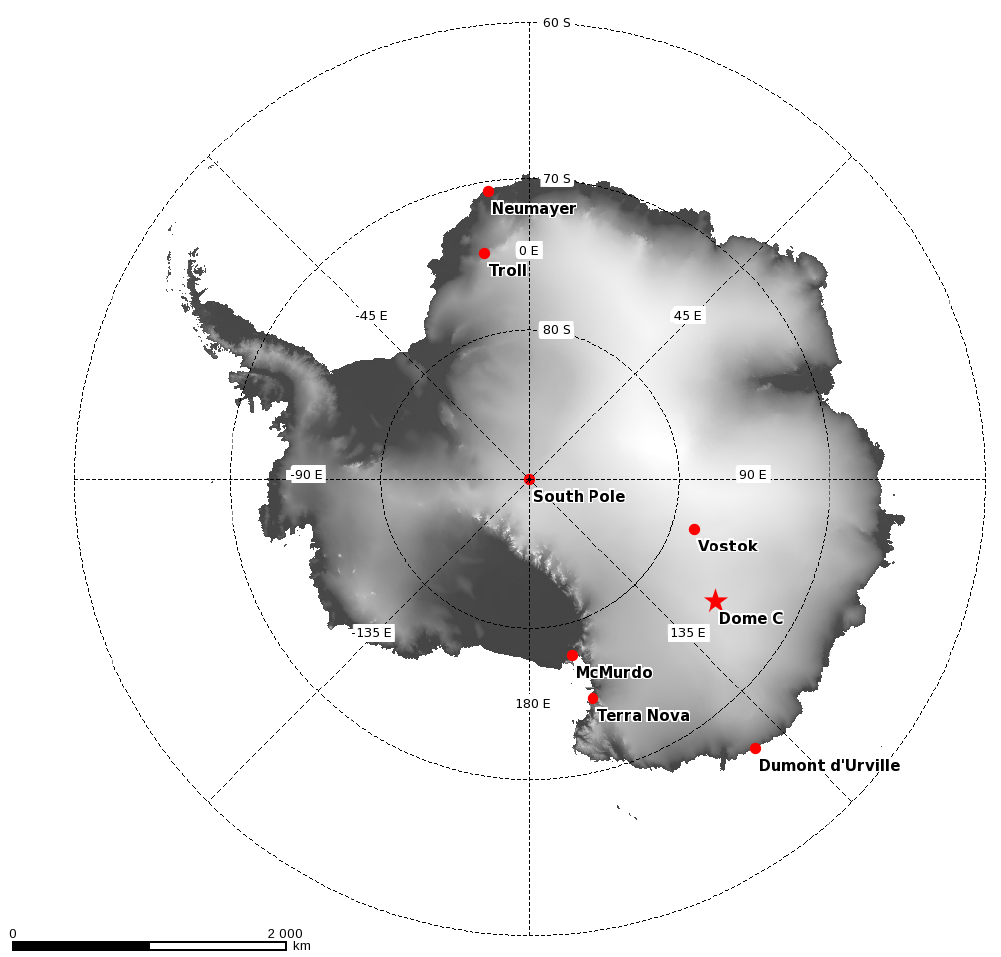
Fig. 2. Location of Dome C on a geographic map of Fig. 2 : Location of Dome C on an Antarctic geographic map.